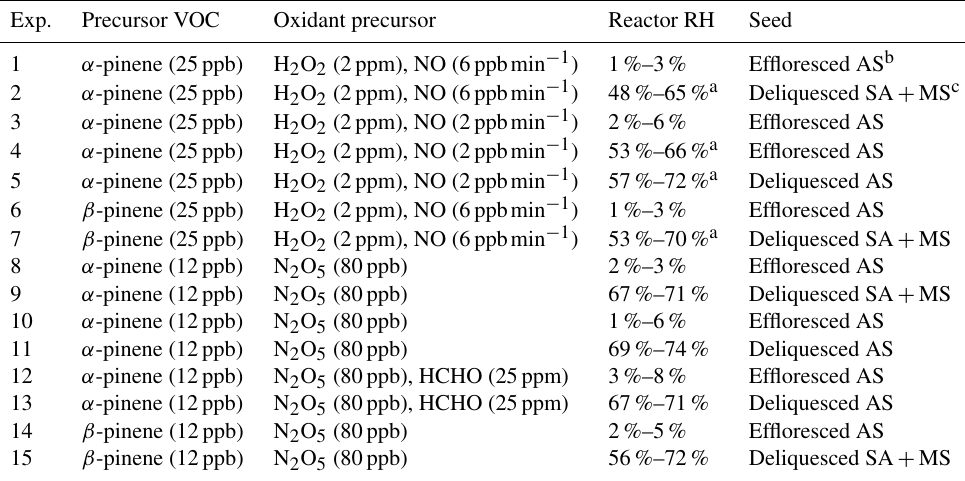
Table 1. Summary of experimental conditions considered in this study. Exp. Precursor VOC Oxidant precursor Reactor RH